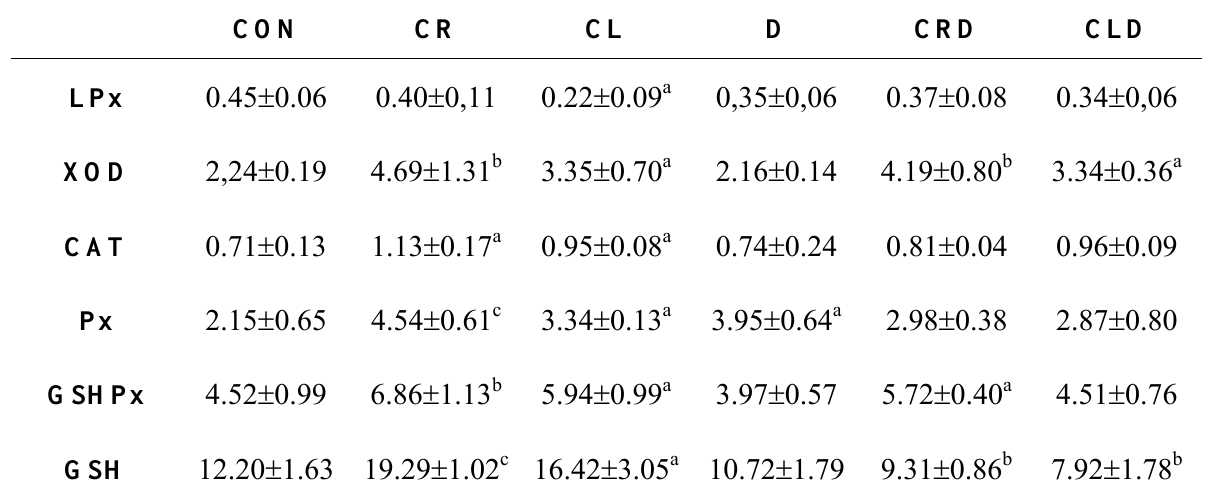
Table 1. Investigated Biochemical Parameters in Liver Homogenate